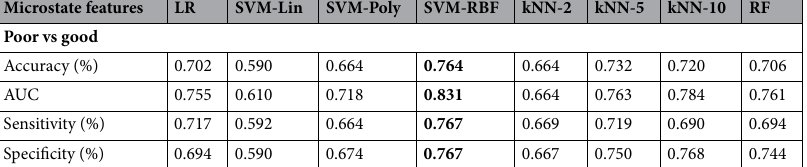
Table 3. Classification performance achieved using eleven microstate features selected by recursive feature elimination from task state EEG recordings in good and poor performers. The results were obtained from five- fold cross validation. The highest classifier performance is bold. LR logistic regression, SVM support vector machine, Lin linear kernel, Poly polynomial kernel, RBF radial basis function, kNN-n k-nearest neighbours with k value of n, RF random